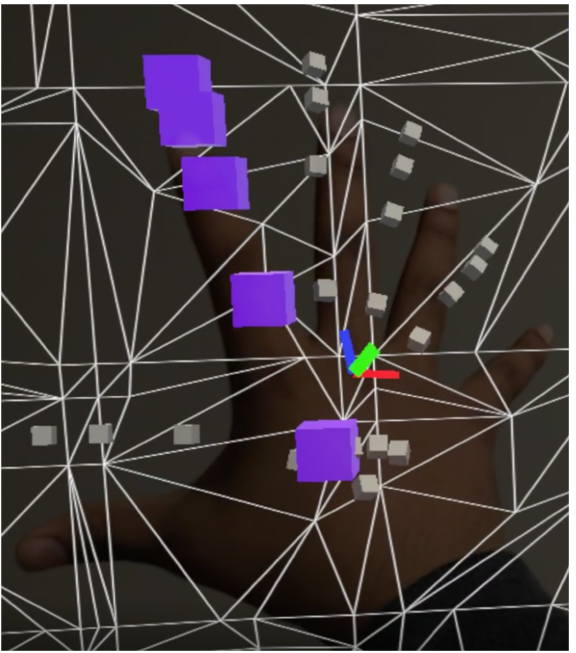
Figure 5. Visual representation of the hand calibration tool in